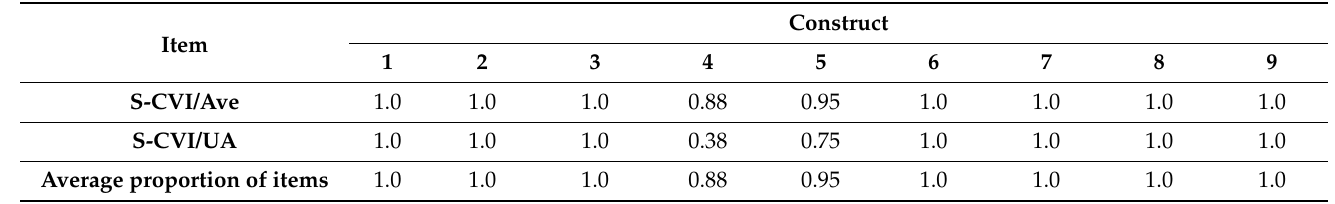
Table 2. Content validity index based on the construct to measure the factors influencing the community willingness to perform CPR and use an AED by five experts.